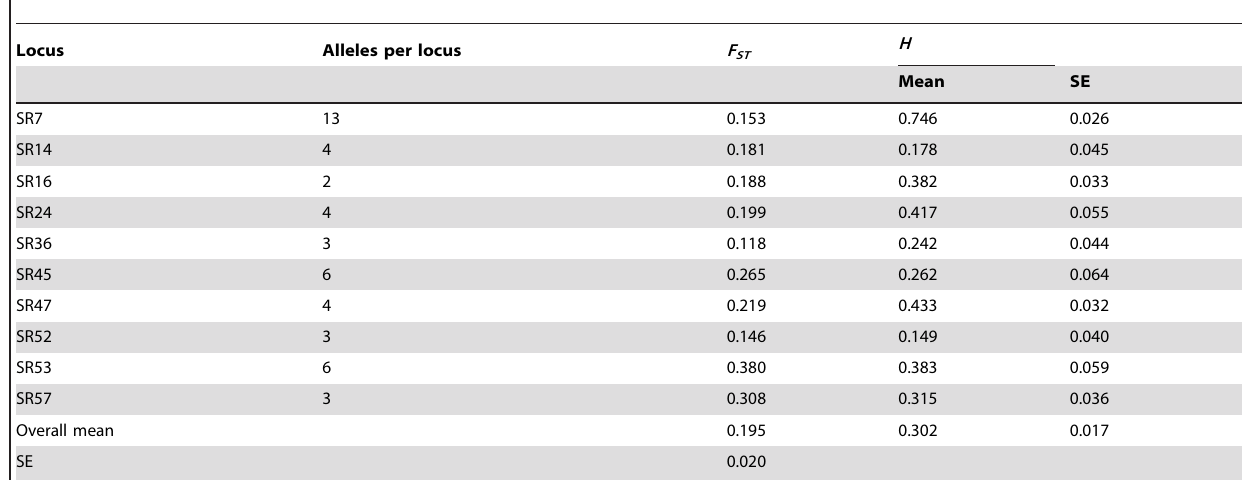
Table 2. Summary of F ST and heterozygosity ( H ) from each locus in L. longiclavatum populations (clone corrected data, n =218).